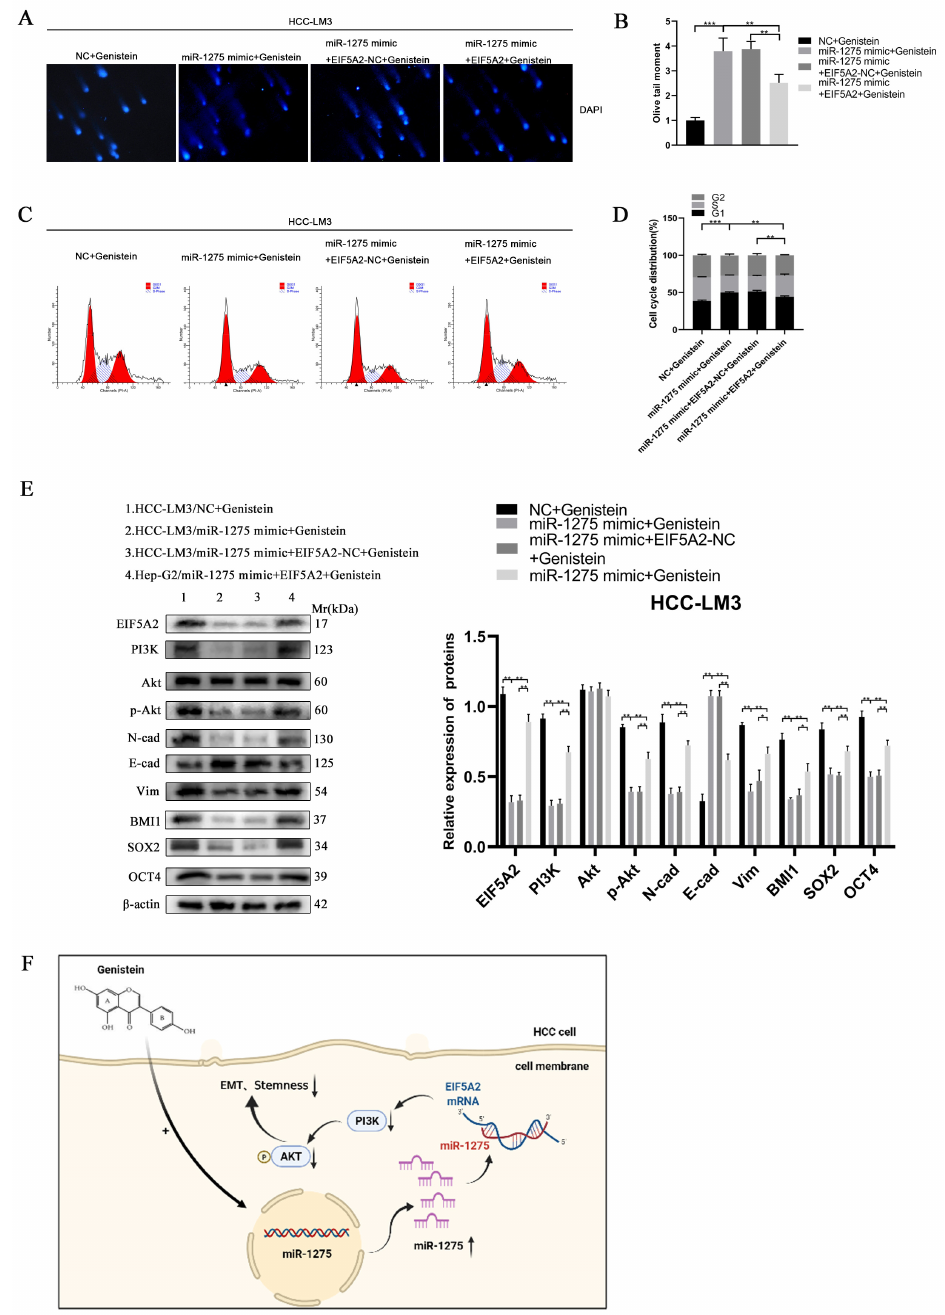
Figure 6. The inhibitory effect of miR-1275 upregulated by genistein on the EMT and stemness of HCC can be reversed by the activation of the EIF5A2/PI3K/Akt signaling pathway. ( A , B ) Comet